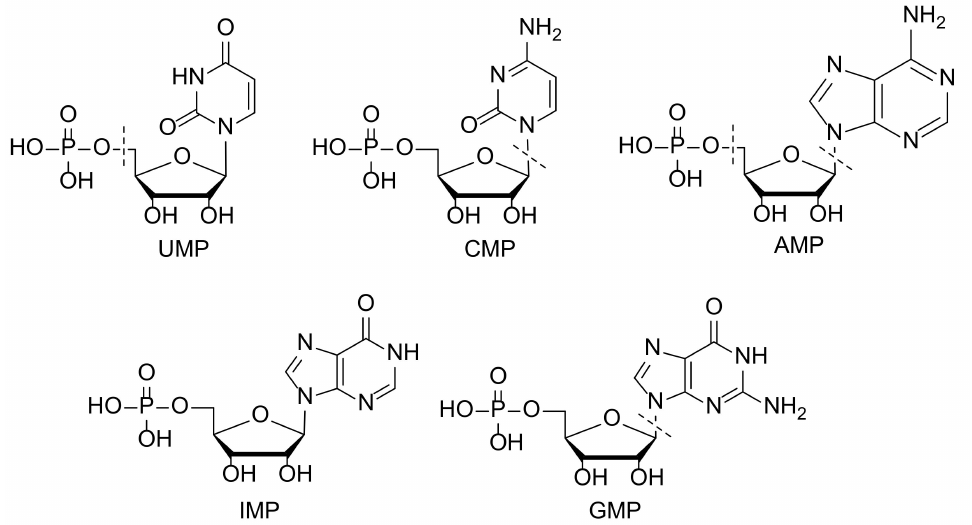
Figure 1. Chemical structural formulas of five